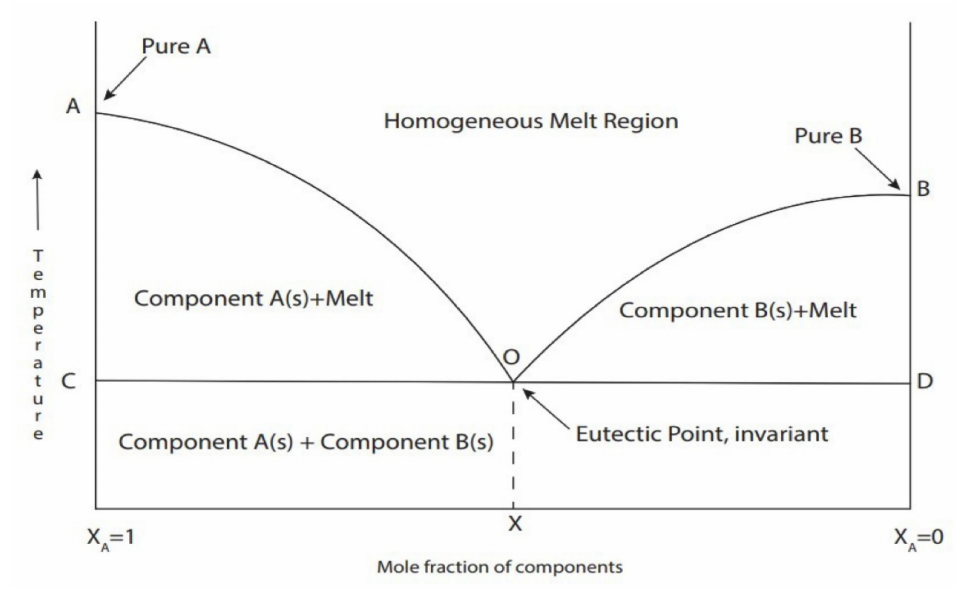
Figure 3. Schematic representation of the DES at the eutectic point. The solid line shows the melting temperature as a function of the mole fraction of components in the mixture and the dashed lines show the temperature and composition of the eutectic mixture. Reprinted with permission from [54].